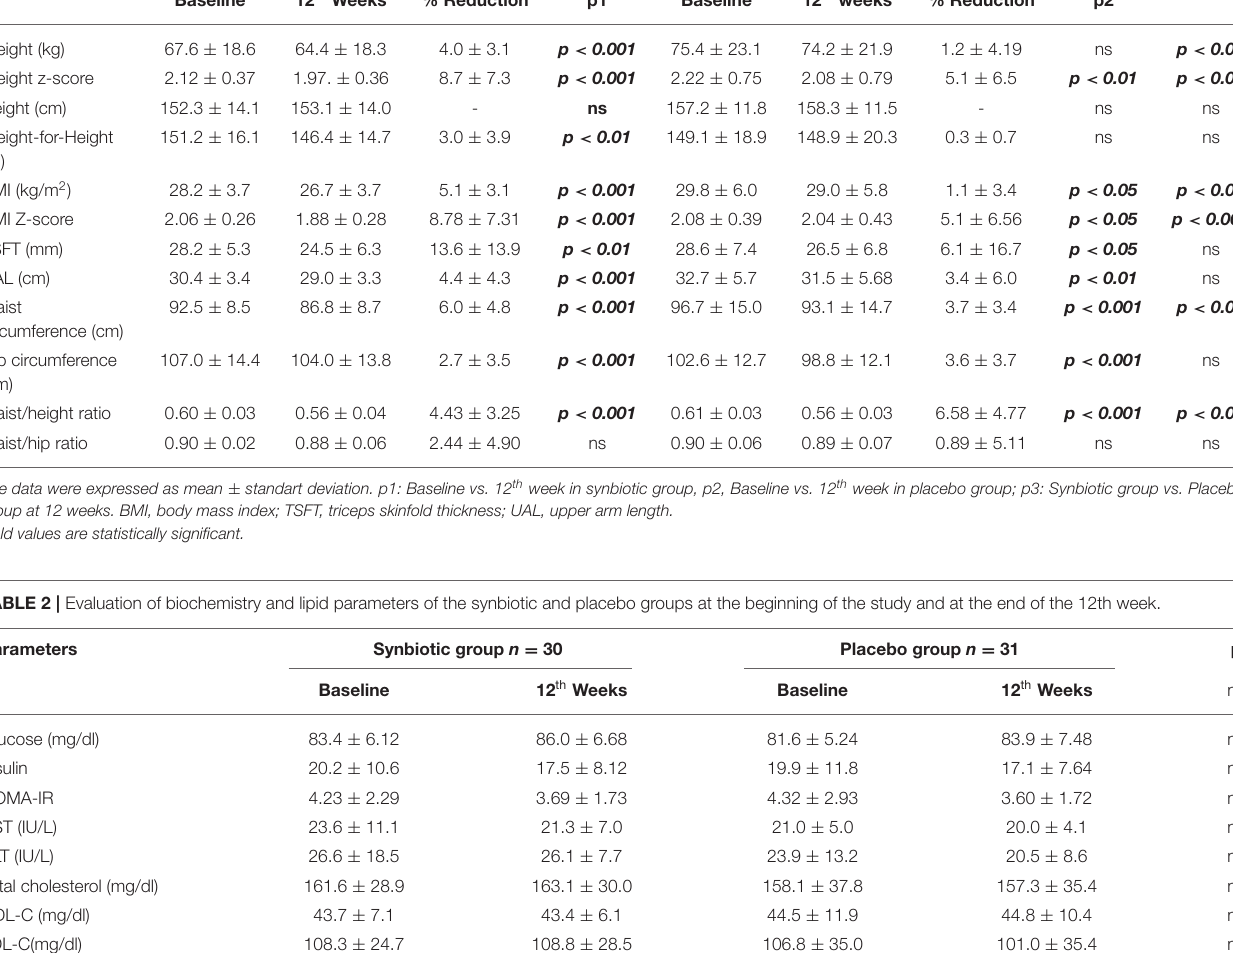
TABLE 1 | Evaluation of the change in anthropometric measurements of the synbiotic and placebo groups at the beginning of the study and at the end of the 12th week. Parameters